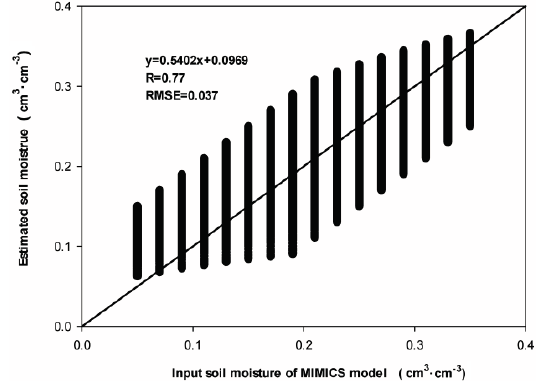
Figure 3. Comparison between retrieval results from model (5) and soil moisture imported to the MIMICS